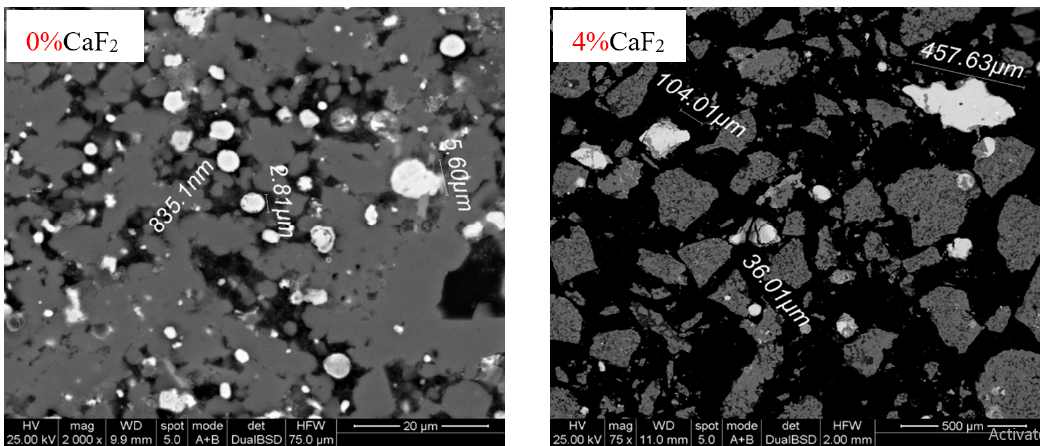
Figure 4. Scanning electron microscopy (SEM) image of the reduction calcines in 0% and 4% CaF 2.